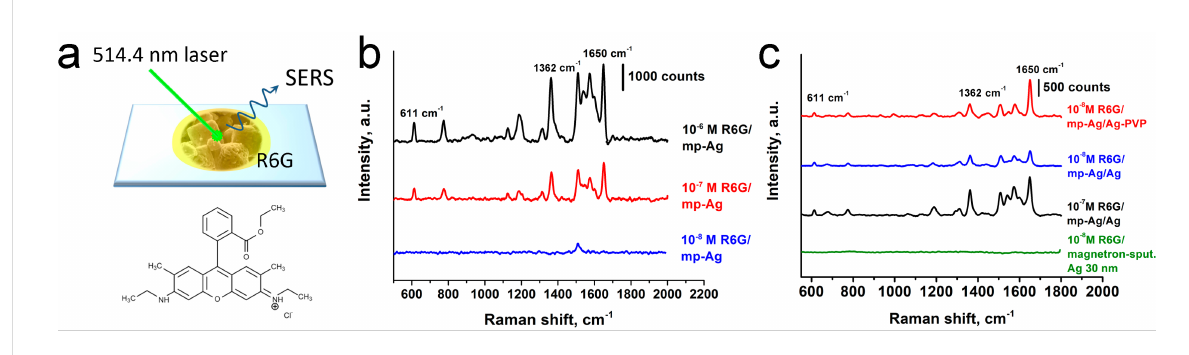
Figure 4: (a) The principal scheme of SERS experiment and (b) corresponding SERS spectra of rhodamine 6G in 10 − 8 M, 10 − 7 M and 10 − 6 M con- centrations obtained using the substrates of mesoporous Ag microcubes synthesized at Ag 2 O/NaBH 4 1:10 ratio. (c) SERS spectra of rhodamine 6G in 10 − 7 M and 10 − 8 M 1–2 μ L aliquots collected using mp-Ag/Ag slides prepared with or without PVP.